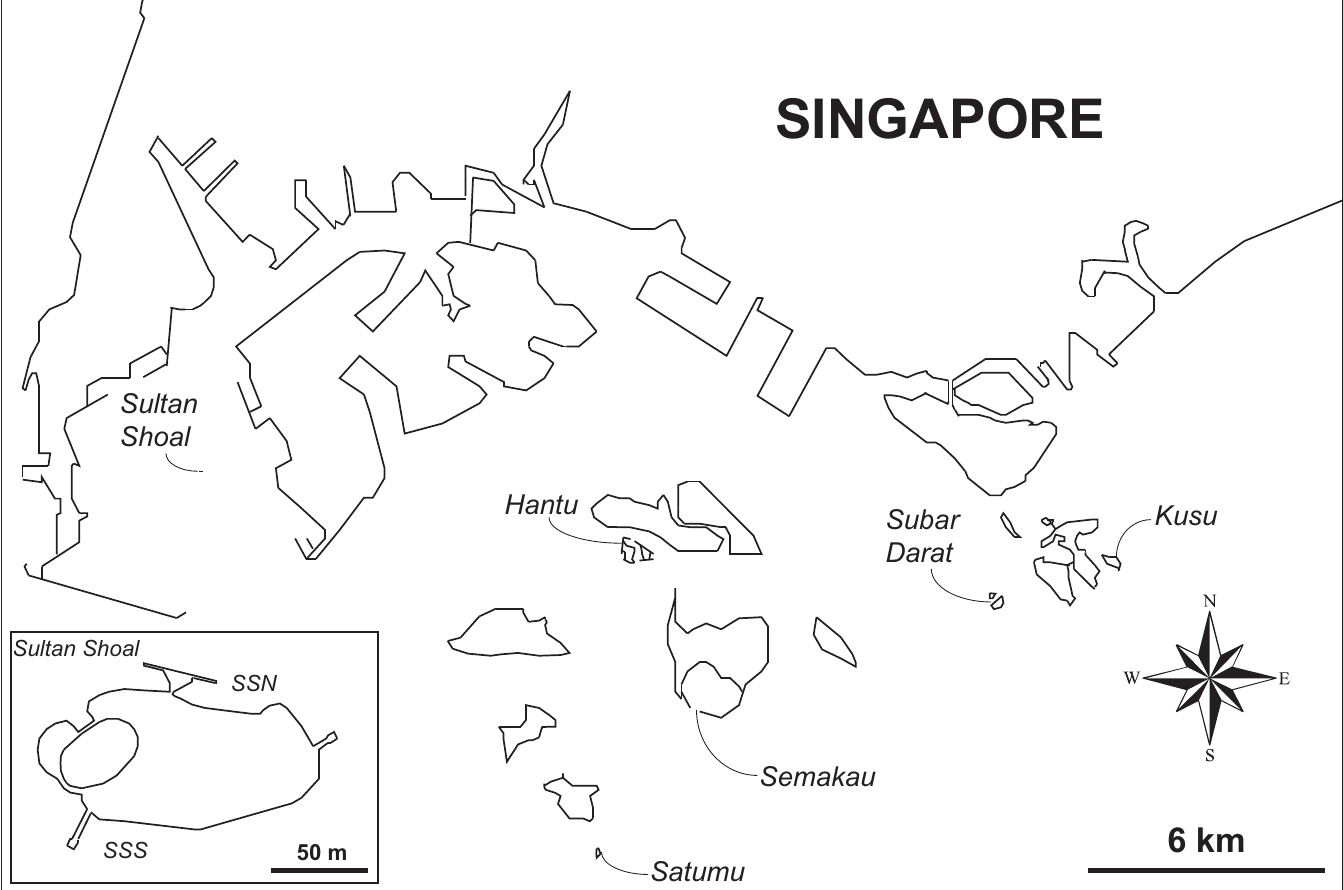
Fig 1. Map of the southern islands of Singapore, with inset showing Sultan Shoal. The seven study sites are indicated (SSN = Sultan Shoal North; SSS = Sultan Shoal South).